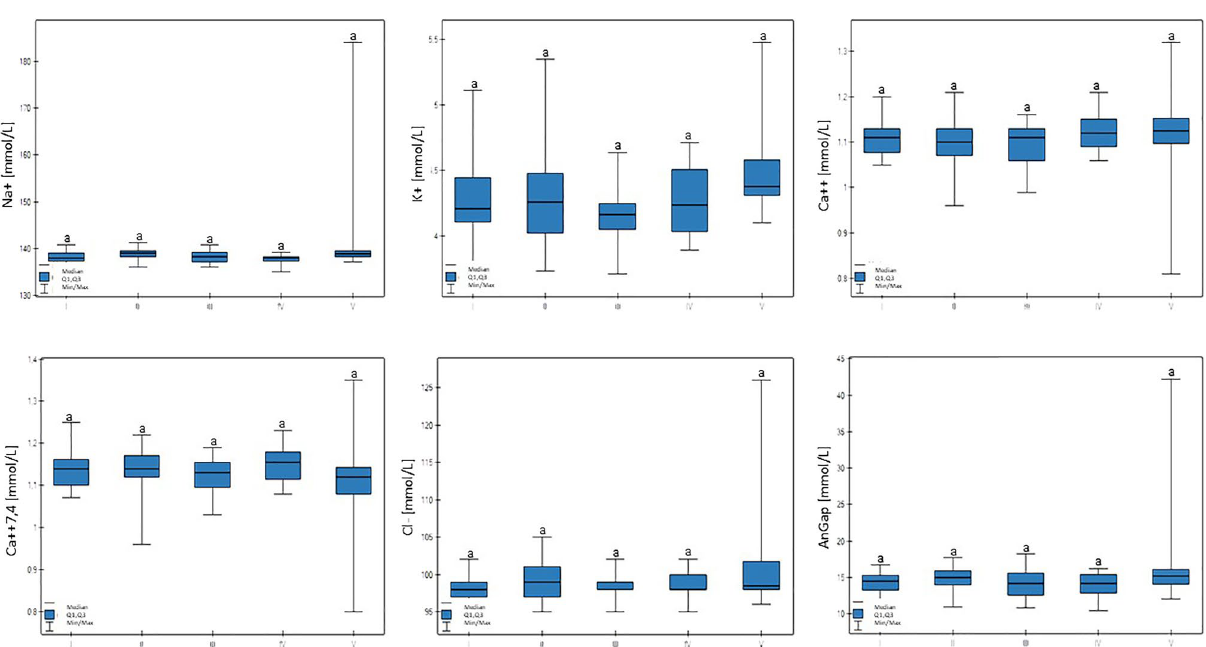
Figure 5. Differences in Na + , K + , Ca + + , Ca + + (7,4), Cl − , and AnGap (anion gap) values in cows at different production levels. In the box plots, the upper whisker represents the maximum value; the upper line of the box represents Q3 (upper quartile); the center line inside the box represents the median; the lower line of the box represents Q1 (lower quartile); and the lower whisker represents the minimum value. Groups marked by letters (a–b) differ significantly, p ≤ 0.05. The cows were divided in to five groups: I—44–39 kg milk/cow; II—38–31 kg milk/cow; III—30–26 kg milk/cow; IV—25–20 kg milk/cow; and V—19–17 kg milk/cow, based on mean daily milk